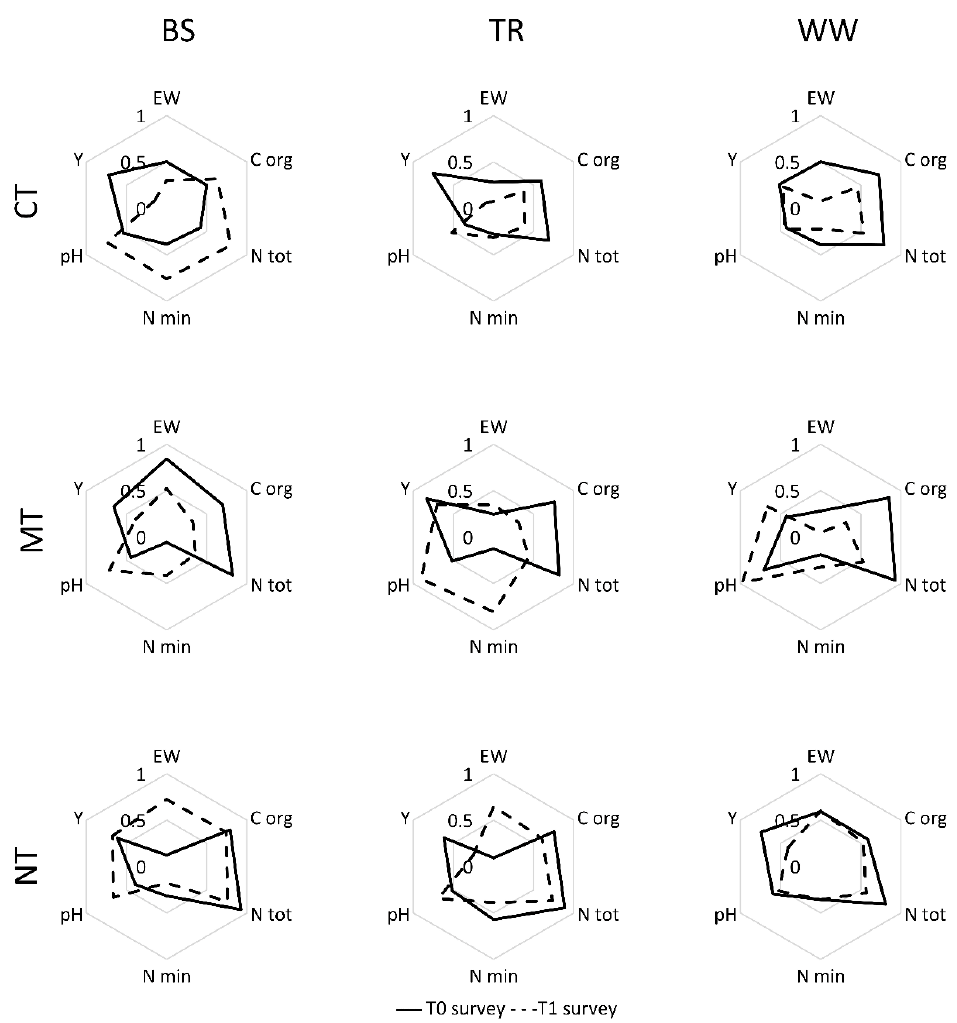
Figure 1. Biochemical parameter scores with average values in treatment combinations at T0 and T1 surveys (C org—soil organic carbon; N tot—soil total nitrogen; EW—earthworm den- sity; N min—mineral nitrogen; Y—yield; BS—bare soil; TR—tillage radish; WW—winter wheat; CT—conventional tillage; MT—minimum tillage; NT—no